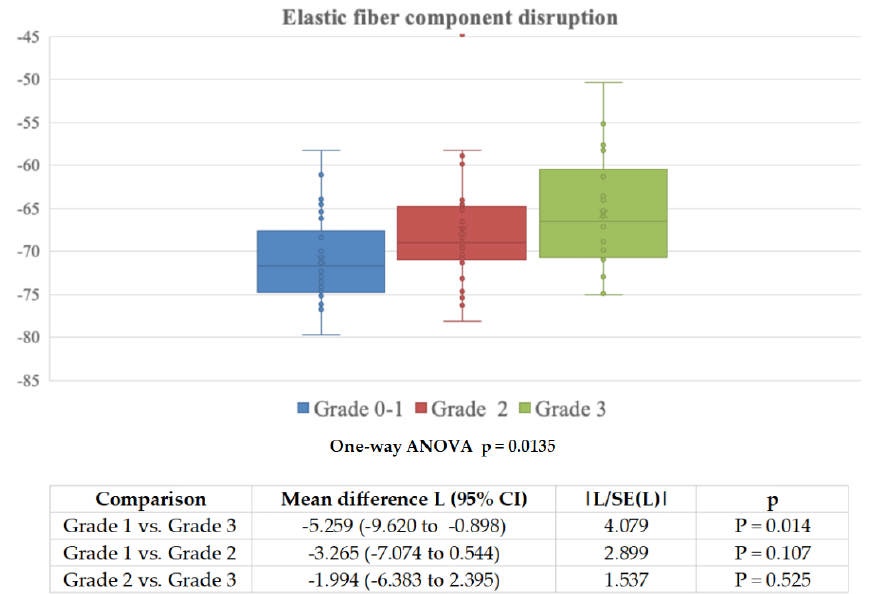
Figure 7. Mean fat attenuation in each group of patients divided based on elastic fibers disruption grade and p for significance of one-way analysis of variance (Welch adjusted ANOVA), with Tukey – Kramer multiple comparisons.